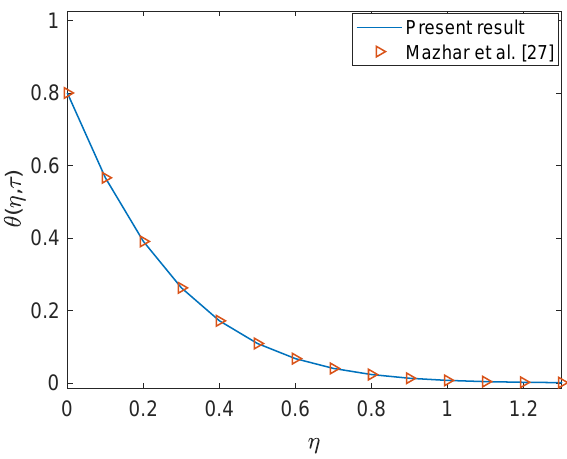
Figure 11. Temperature comparison.